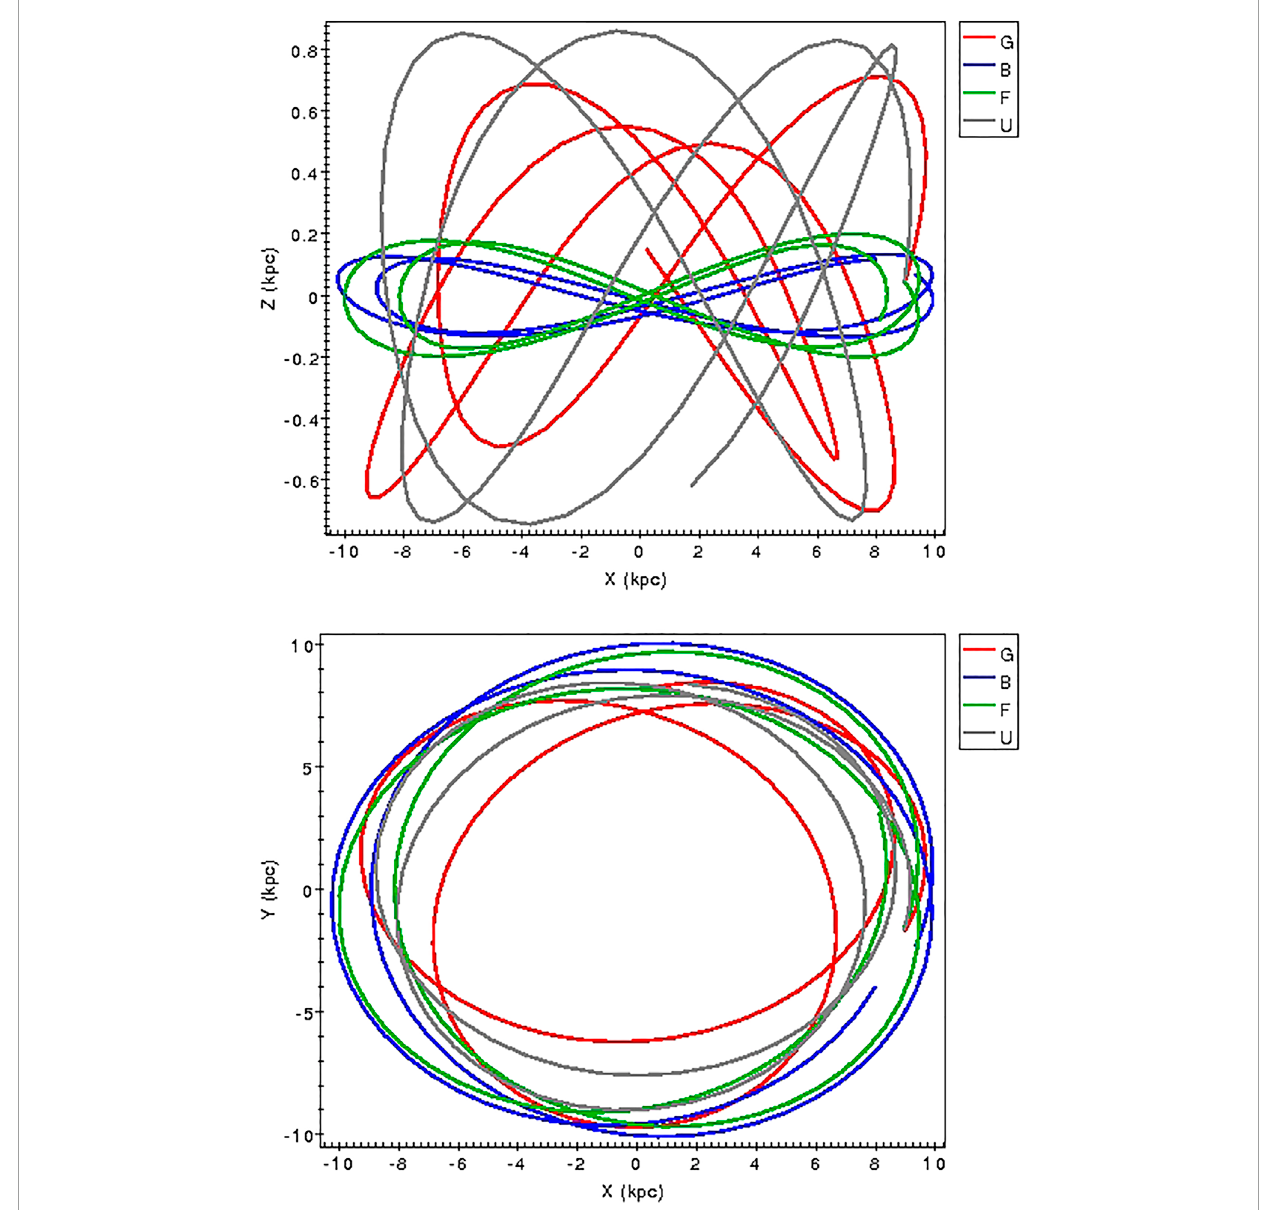
FIGURE A9 These Figures show the orbits of the stars with the new Gaia DR3 proper motion data. There are no substantial changes compared to our 2019 exploration where we used the Gaia DR2 . The orbits of stars B (blue), G (red), F (green) and U (gray), projected on the Galactic meridian plane (up) and on the Galactic plane (bottom), computed forward on time for the next 500 Myr. In the upper panel, we see that star U reaches the largest distance from the Galactic plane, followed by star G, while stars B and F scarcely depart from the plane. The behaviour of the latter stars is typical of the rest of the sample considered here. In the bottom panel, we see that the orbit of star G, on the Galactic plane, is quite eccentrical, which corresponds to the high value of the proper motion and V R compared to the sample, while the other stars (including star U) have orbits close to circular. Also here, the behaviour of stars B and F is representative of the whole sample. Star E has a similar orbit than stars B and